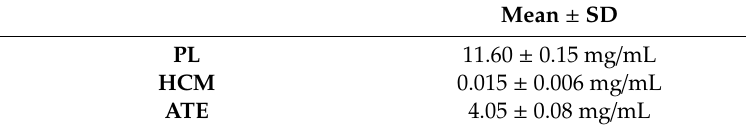
Table 1. Total protein content of the di ff erent growth factor mixtures ( n = 3).